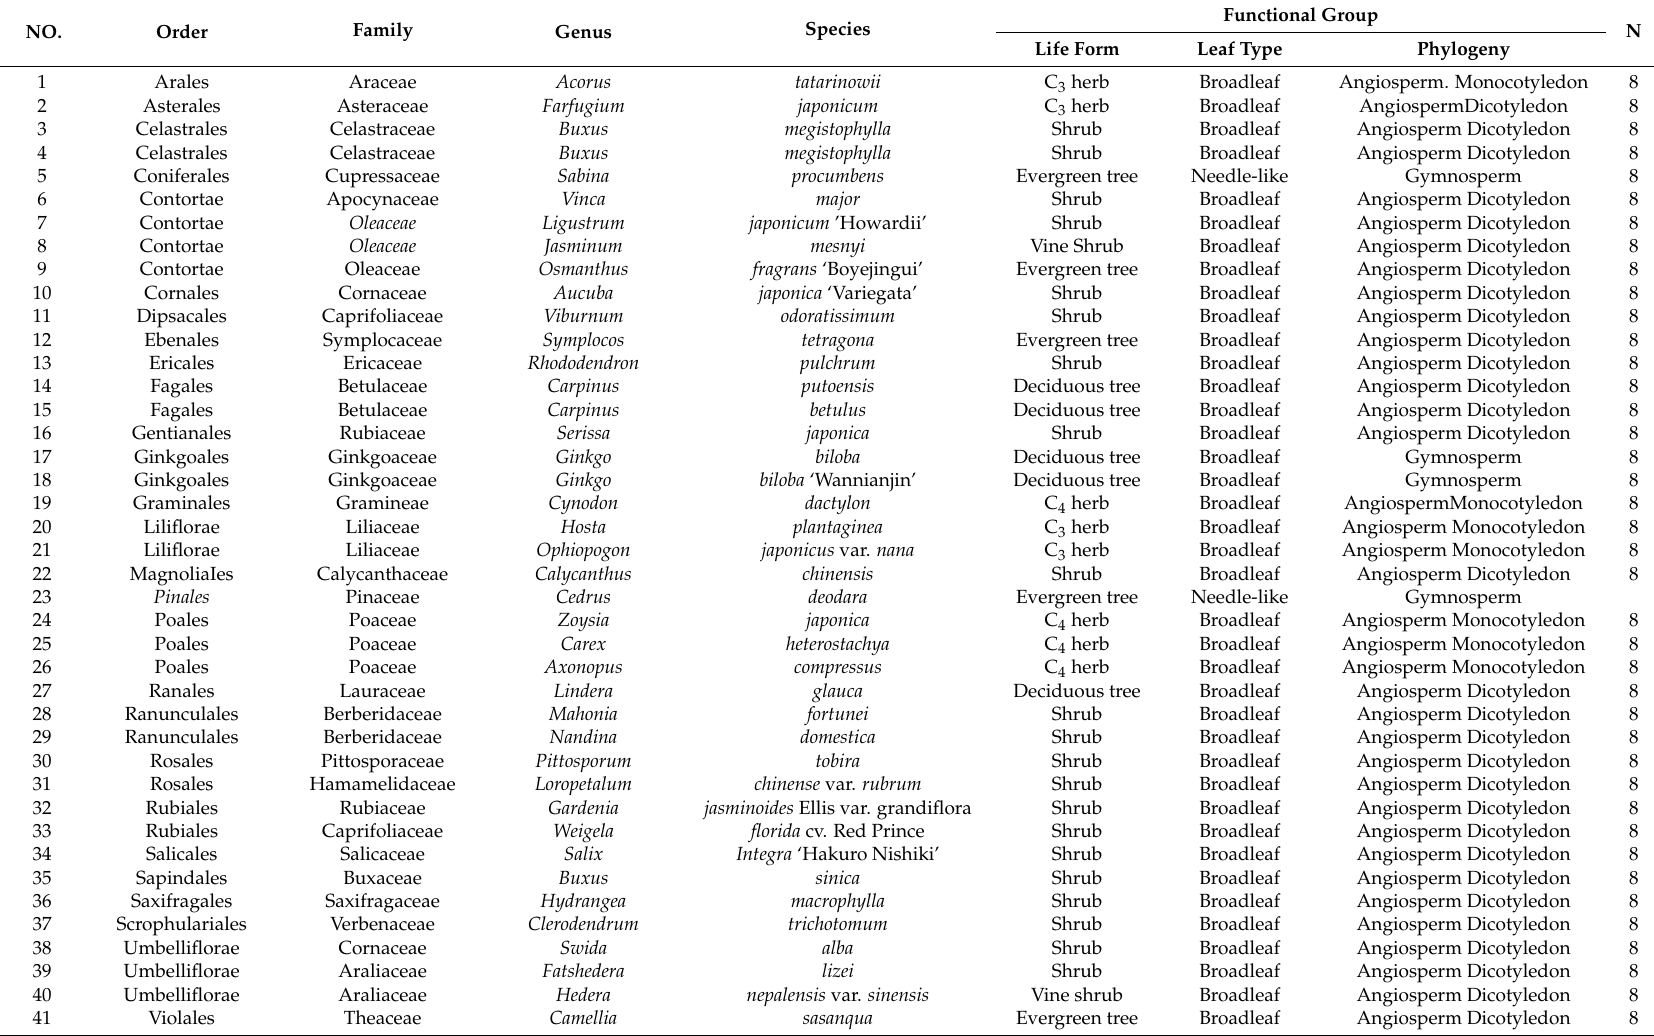
Table 1. 41 plant species used in this study and their corresponding Angiosperm Phylogeny Group (APG) (APG, 1998) and plant functional group classification.